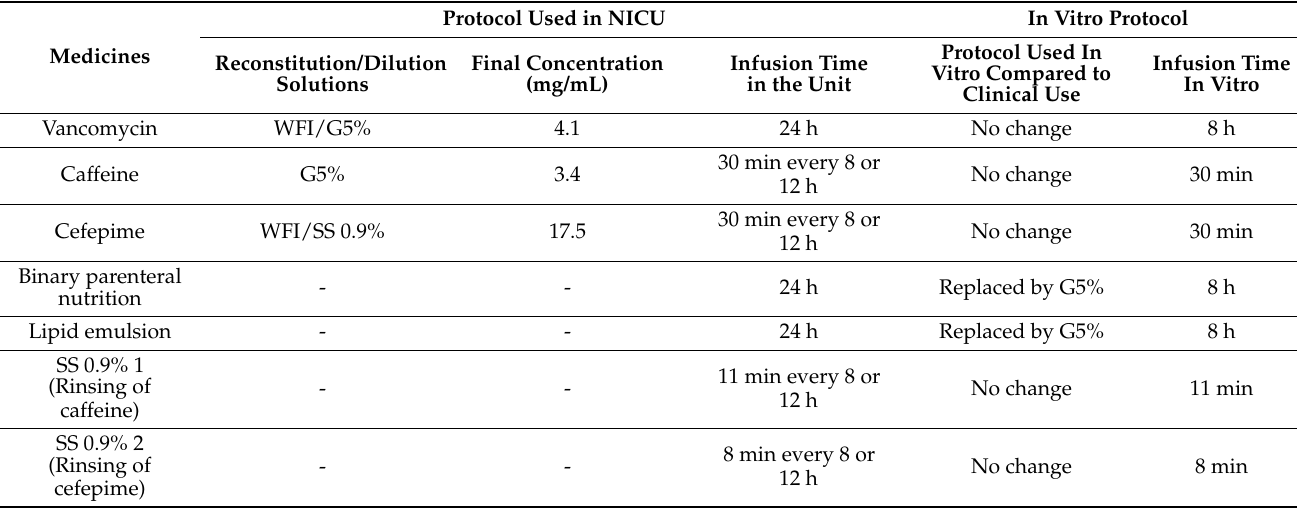
Table 1. Reconstitution, dilution, concentration, rate and time of infusion of the different drugs applied in the in vitro protocol (WFI: Water for injections, SS: Saline solution, G5%: 5% Glucose solution). Protocol Used in NICU In Vitro Protocol Medicines Reconstitution/Dilution Final Concentration Solutions (mg/mL)